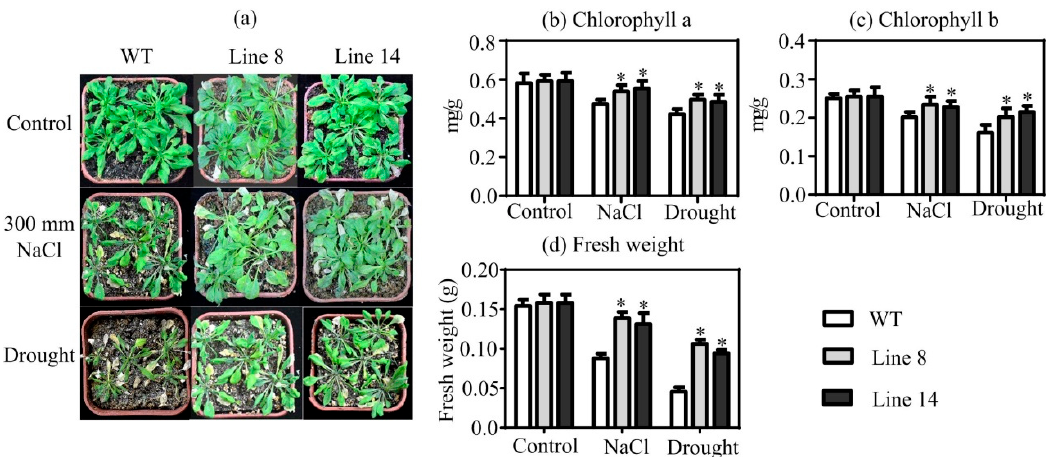
Figure 4. SaNADP-ME4 confers NaCl and drought stress resistance. ( a ) The growth of WT and two overexpressing lines were compared under the control, 300 mm NaCl, and drought stress conditions for seven days. ( b – d ) The chlorophyll a content ( b ), chlorophyll b content ( c ), and fresh weight ( d ) were compared under the control, NaCl, and drought stress conditions. Values are means ± SD (standard deviation). Asterisk indicates a significant difference at the p < 0.05 significance level, as determined with SPSS v. 19.0.